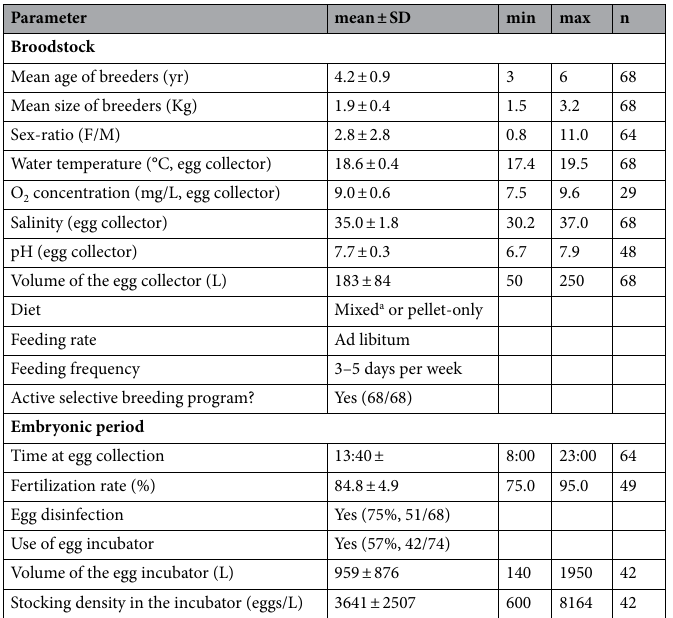
Table 1. Range of the main rearing parameters during the broodstock management and embryonic period. n, number of reported values (cases). a Mixed diet, with use of frozen fish (e.g. sardines, squids) and commercial